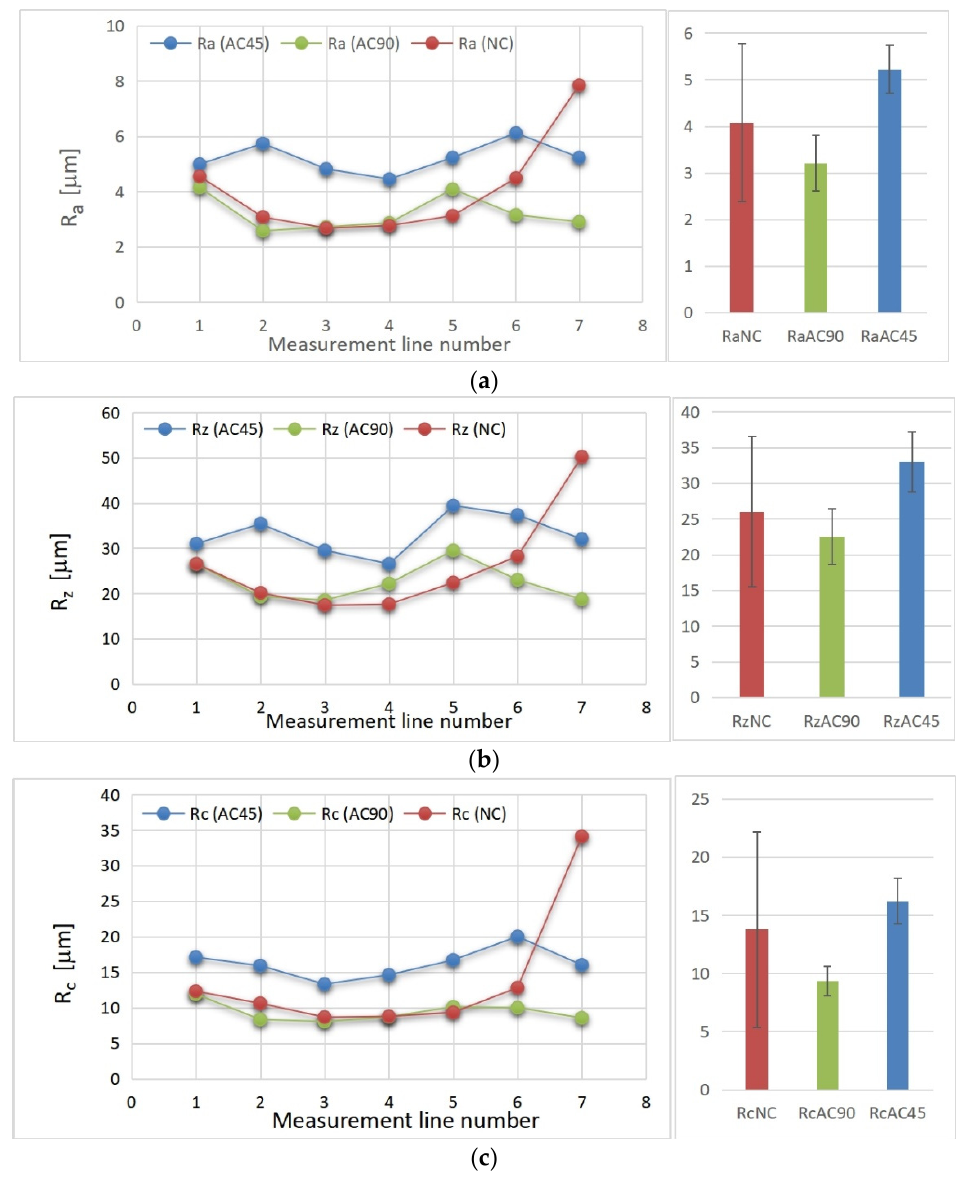
Figure 5. Roughness parameter values: Ra ( a ), Rz ( b ) and Rc ( c ). Table 3. Mean values of Rz, Ra, Rc parameters with the determined confidence